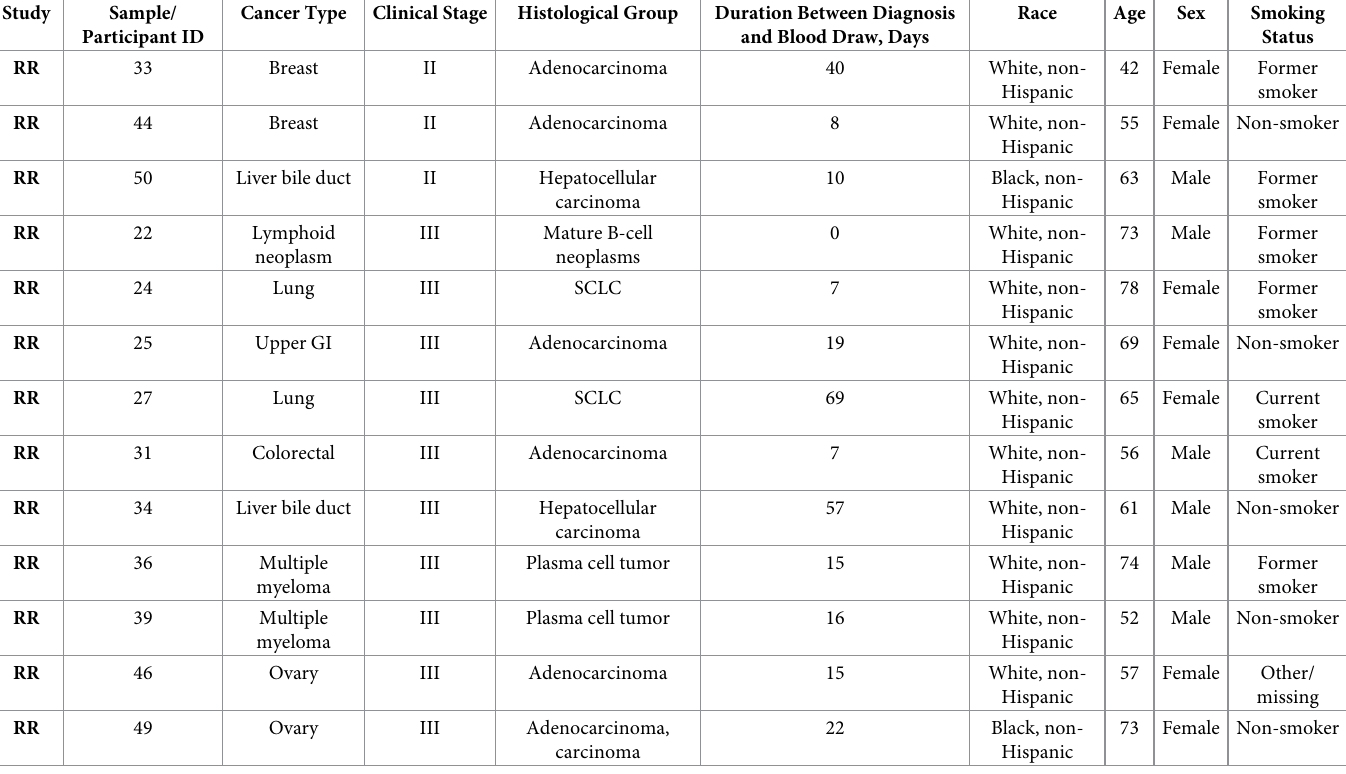
Six non-cancer samples tested in quadruplicate were correctly classified as non-cancer in 24/24 tests (100% specificity; 95% confidence interval [CI], 85.8–100%). In addition, among 1204 non-cancer samples from 583 unique individuals without cancer, 1195 were correctly classified as non-cancer (99.3% specificity; 95% CI, 98.6–99.7%) ( S3 Table ). Among the 9 false positives, 8 were from the same 4 participants testing positive twice. For these 4 participants, the cancer signal origin prediction was the same for both replicates from each sample. For the 1 participant who had 1 sample identified as cancer and 1 sample identified as non-cancer, the top cancer signal origin was the same for both samples, suggesting that the underlying signal is an attribute of the sample and not due to an aberrant processing issue. The cancer types and clinical stages for the 600 samples evaluated in the in silico